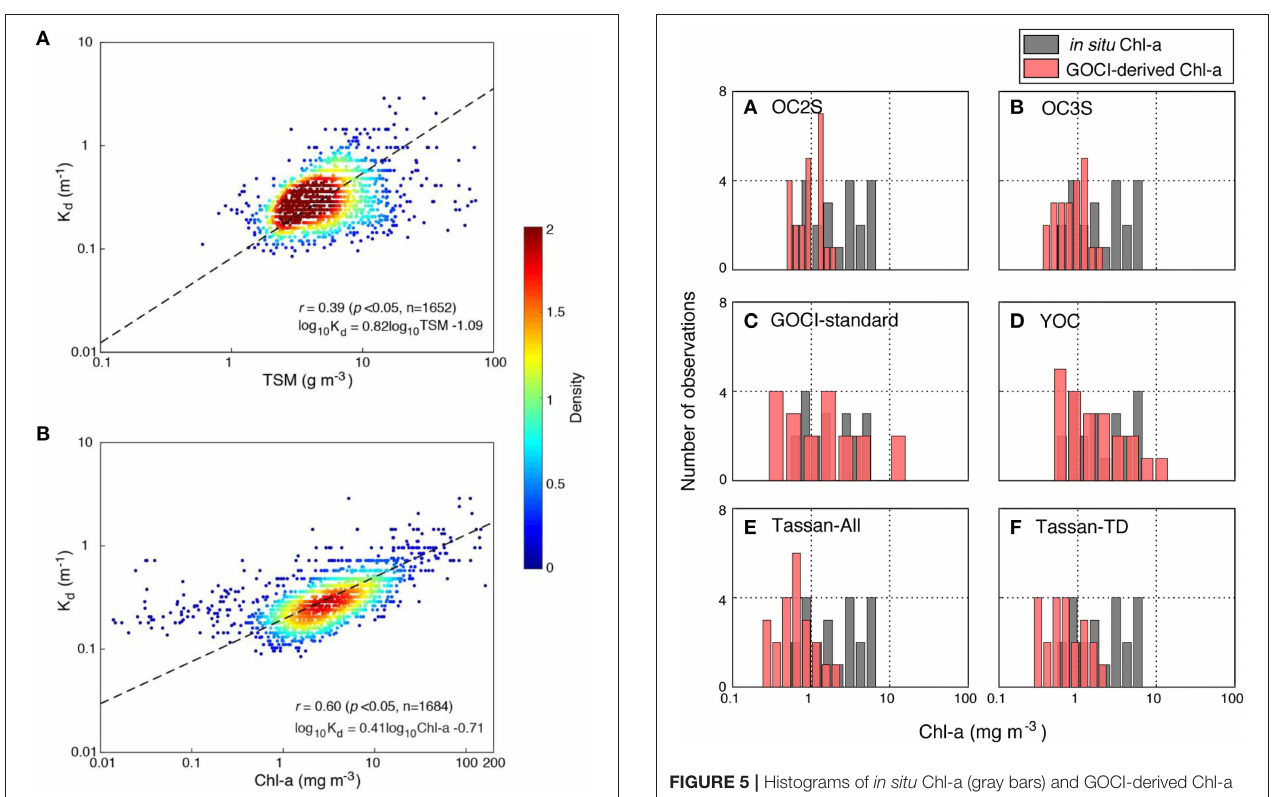
FIGURE 5 | Histograms of in situ Chl-a (gray bars) and GOCI-derived Chl-a obtained using the following six algorithms (red bars): (A) OC2S, (B) OC3S, (C) GOCI-standard, (D) YOC, (E) Tassan-All, and (F) Tassan-TD. ( Figure 7B ). The spatial distributions of the GOCI-derived Chl-a values were calculated using the six Chl-a algorithms, excluding only low-quality pixels that were flagged as cloud or ice, land, atmospheric correction failure, unrealistic R rs spectrum shape, out of GOCI observation boundary, high solar zenith angle ( > 70 ◦ ), high satellite zenith angle ( > 55 ◦ ), or cloud edge.